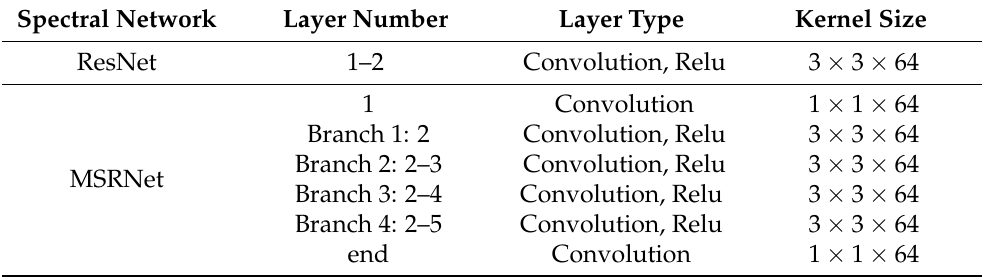
Table 2. The specific parameter settings of the spectral